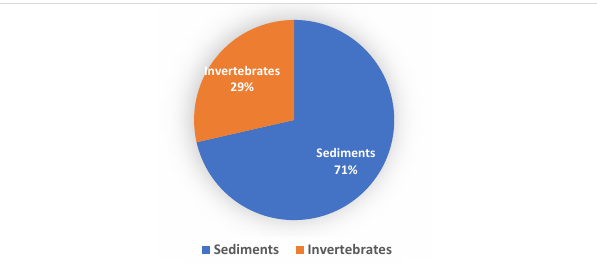
Refer to Supplementary Table S1 for the composition of each media. The superscript ( 2 ) on some media indicates slight changes in the amount of ingredients used. More than 70% of the new Streptomyces spp. were isolated from marine sediments and only 7 (29%) of the new Streptomyces spp. from the marine environment were isolated from marine invertebrates (Figure 2).